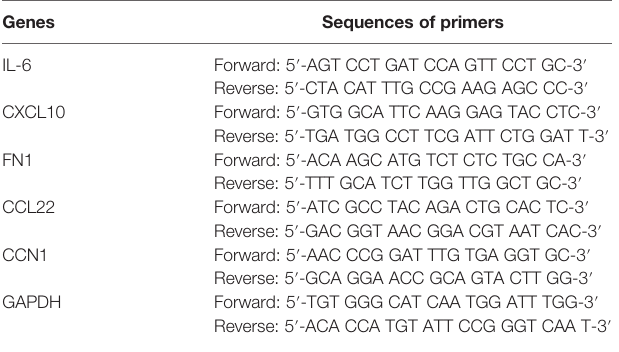
TABLE 1 | Primer sequences used in qRT-PCR. Genes Sequences of